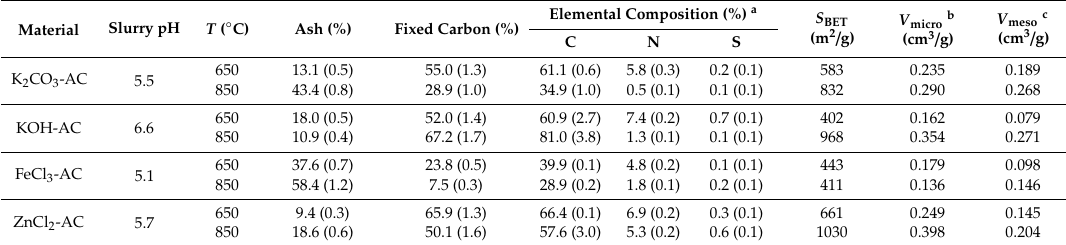
Table 5. Selected properties of the chemically activated